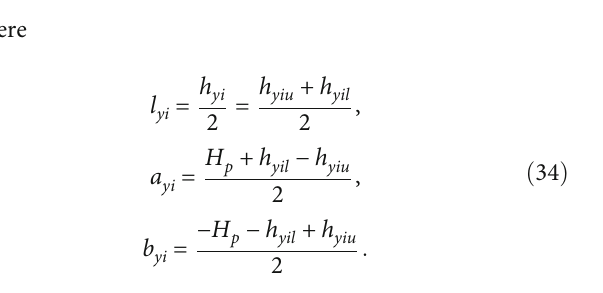
ffiffiffiffiffiffiffiffiffiffiffiffi l − z xj